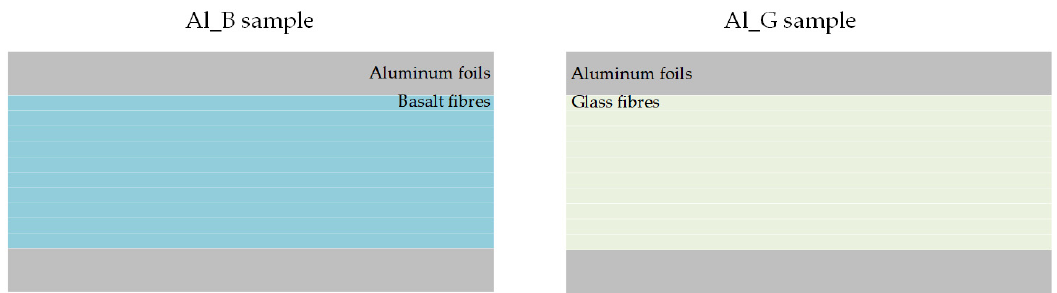
Figure 1. Schematic structures of the specimens.